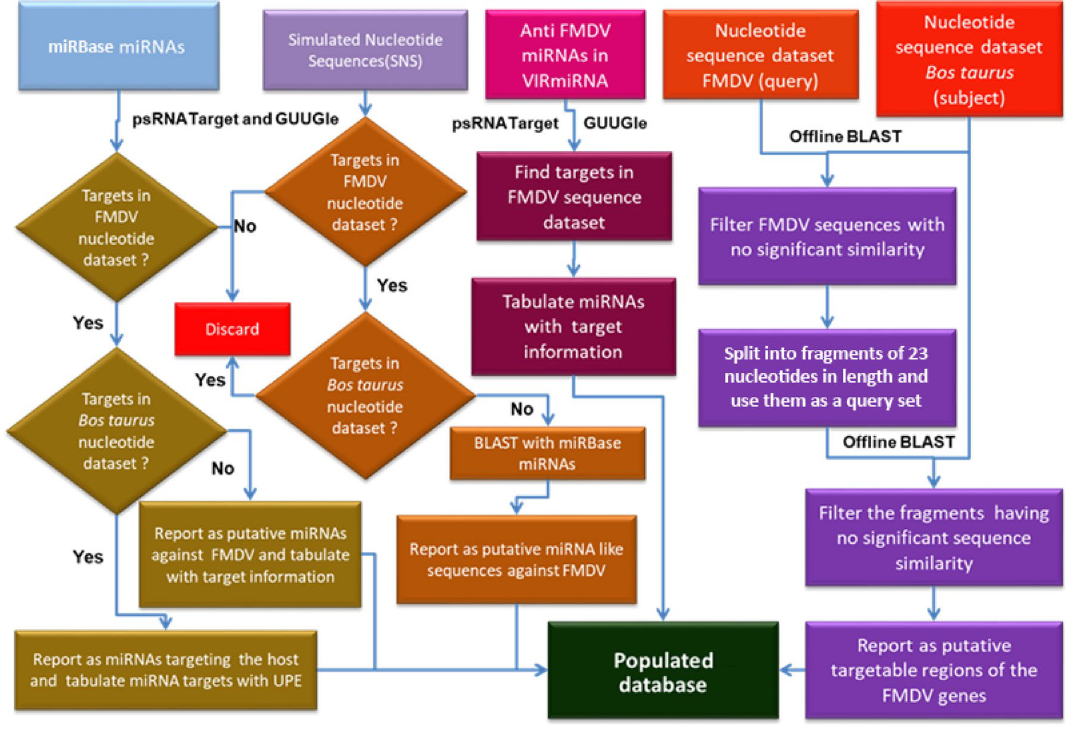
Figure 1. A flow diagram showing identification of anti-FMDV miRNAs and development of a database of miRNAs related to FMD along with their targets. Serial